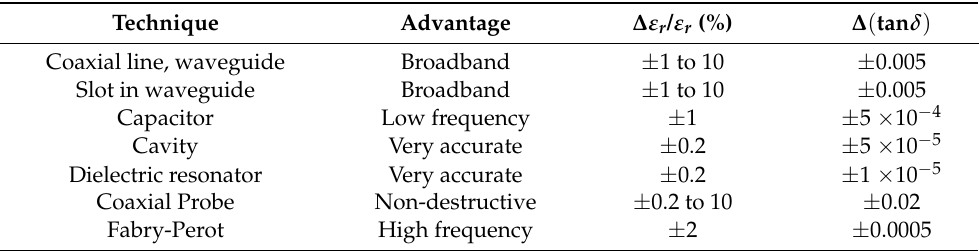
Table 1. Advantages of different dielectric measurement methods and their typical uncertainties of the relative permittivity ( ∆ ε r / ε r ) and loss tangent (tan δ ) [1].